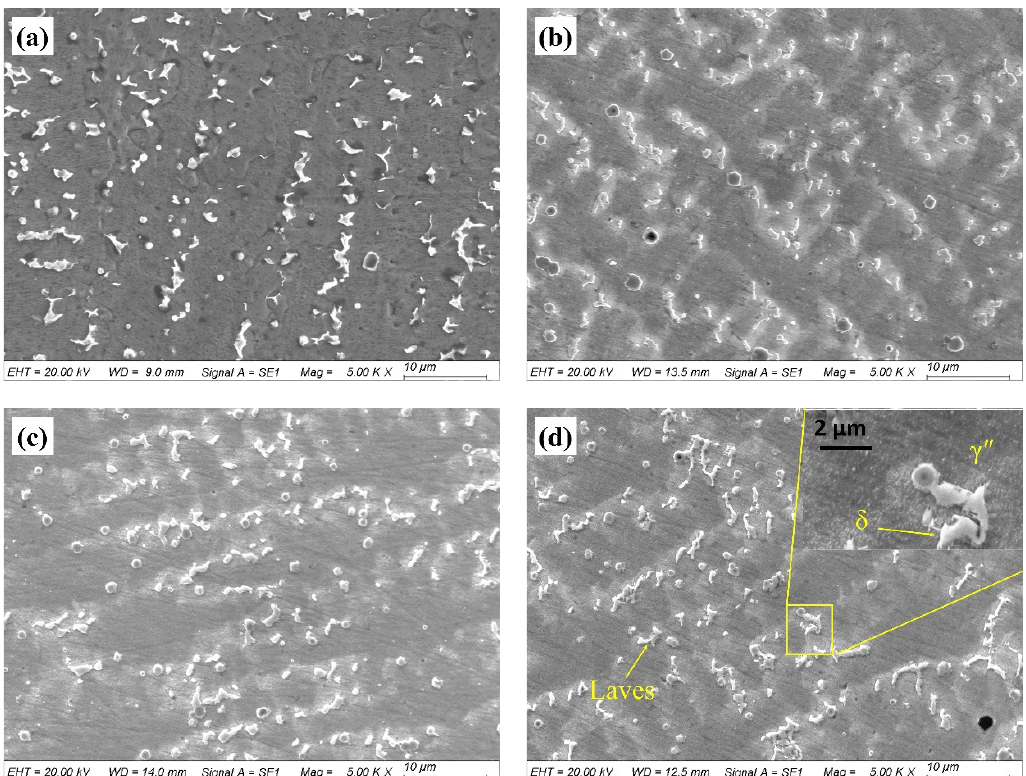
Figure 8. Microstructure of the repaired Inconel 718 alloy specimen exposed to the molten salt at 650 °C for ( a ) 0 h, ( b ) 50 h, ( c ) 100 h, and ( d ) 150 h.